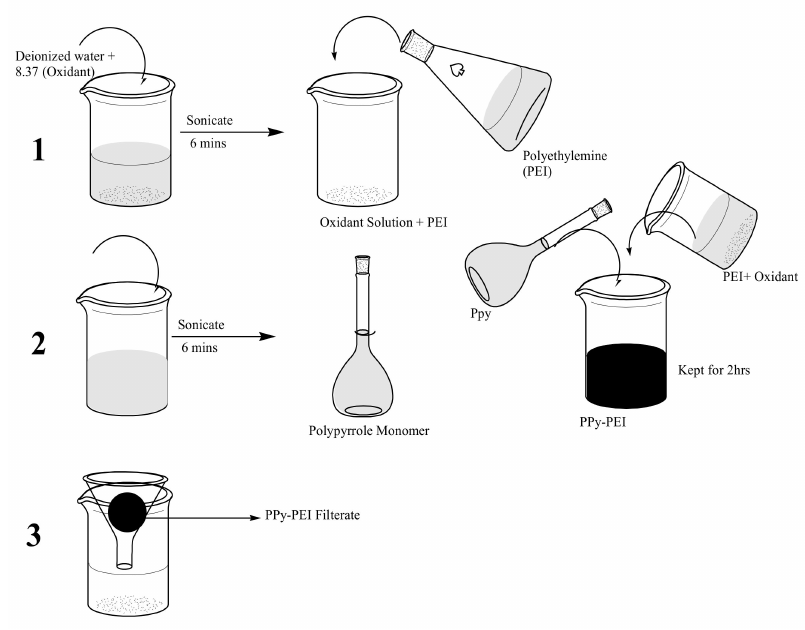
Figure 2. PPy-PEI nano-adsorbent’s synthesis